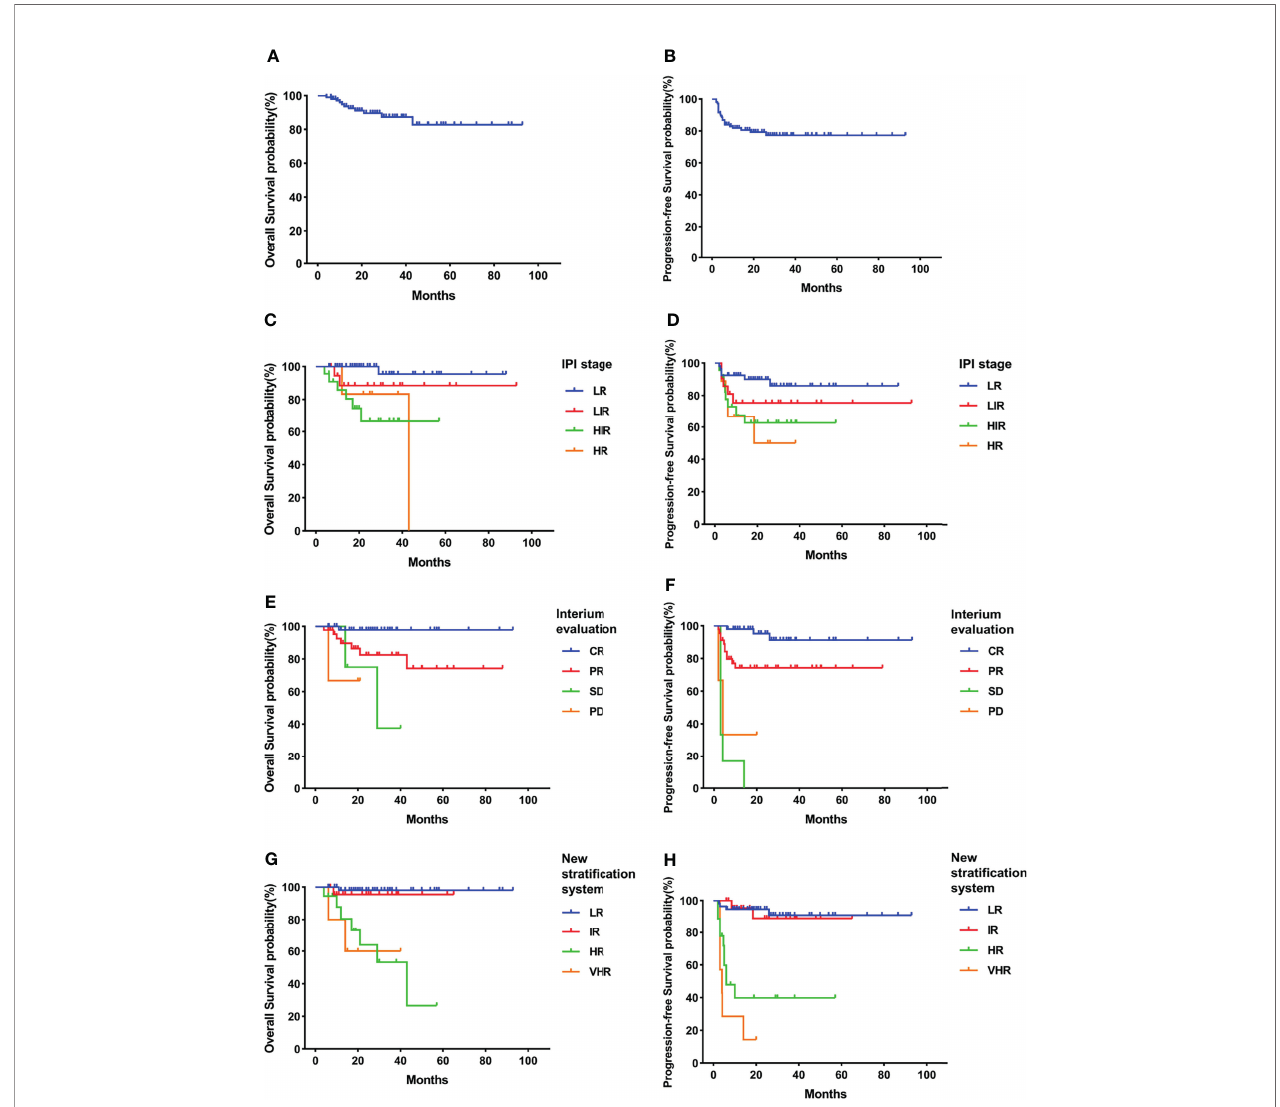
FIGURE 2 | Survival rates of germinal center B-cell (GCB) subgroup. (A) Overall survival (OS). (B) Progressive-free survival (PFS). (C) OS according to International Prognostic Index (IPI) and interim evaluation. (D) PFS according to IPI and interim evaluation. (E) OS when strati fi ed with interim evaluation. (F) PFS when strati fi ed with interim evaluation. (G) OS according to the new risk strati fi cation system by combination of interim evaluation and IPI. (H) PFS according to the new risk strati fi cation system by combination of interim evaluation and